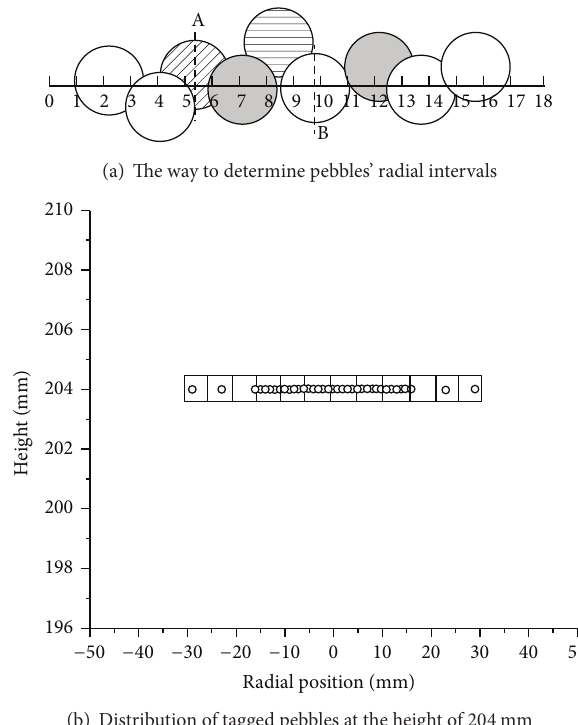
Figure 4: The method to illustrate radial distribution of pebbles.